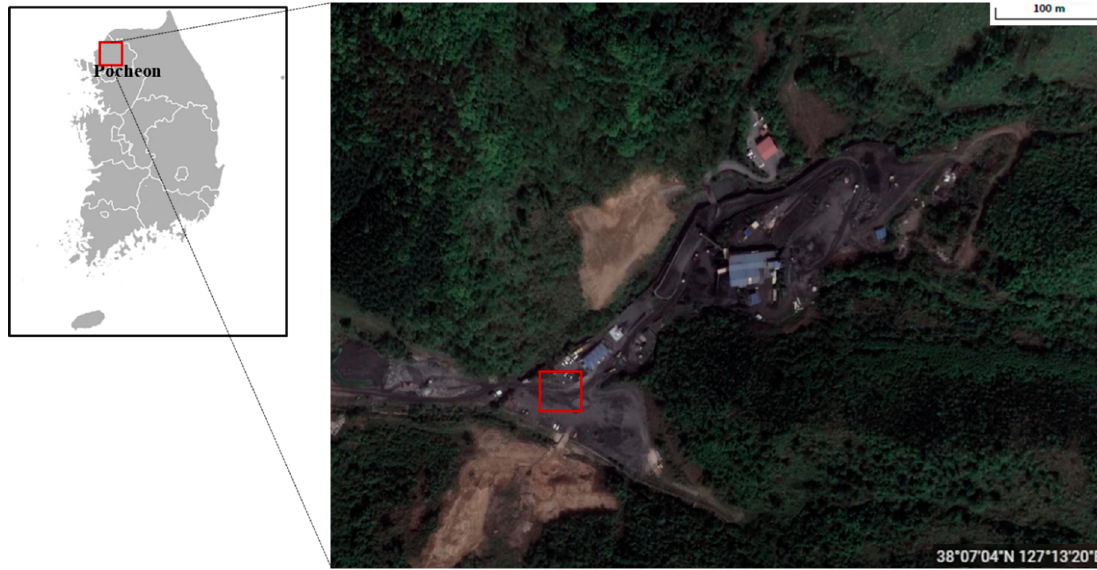
Figure 7. View of the experimental site.